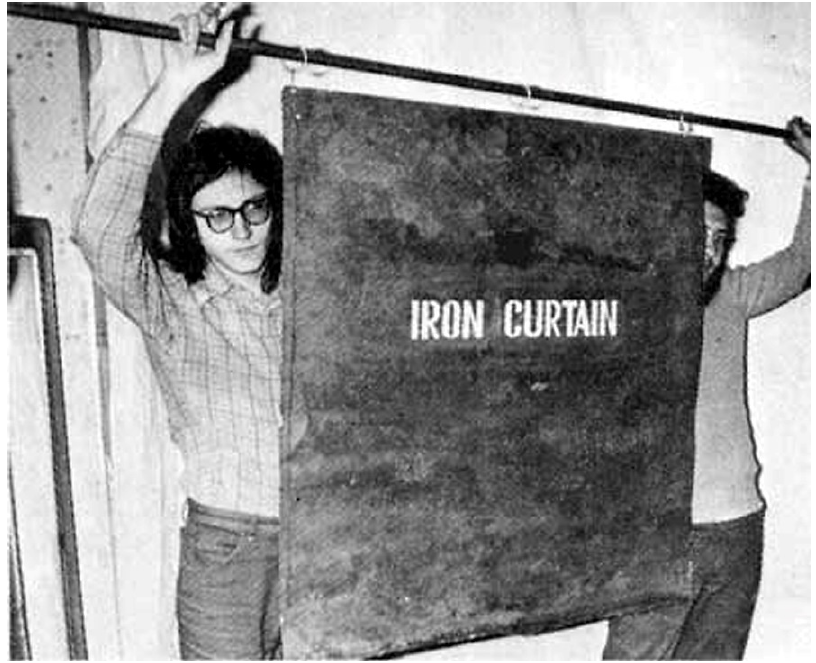
Figure 5. The Nest. Iron Curtain . 1976. Iron, oil, 102 × 100. Image courtesy of Victor Skersis.